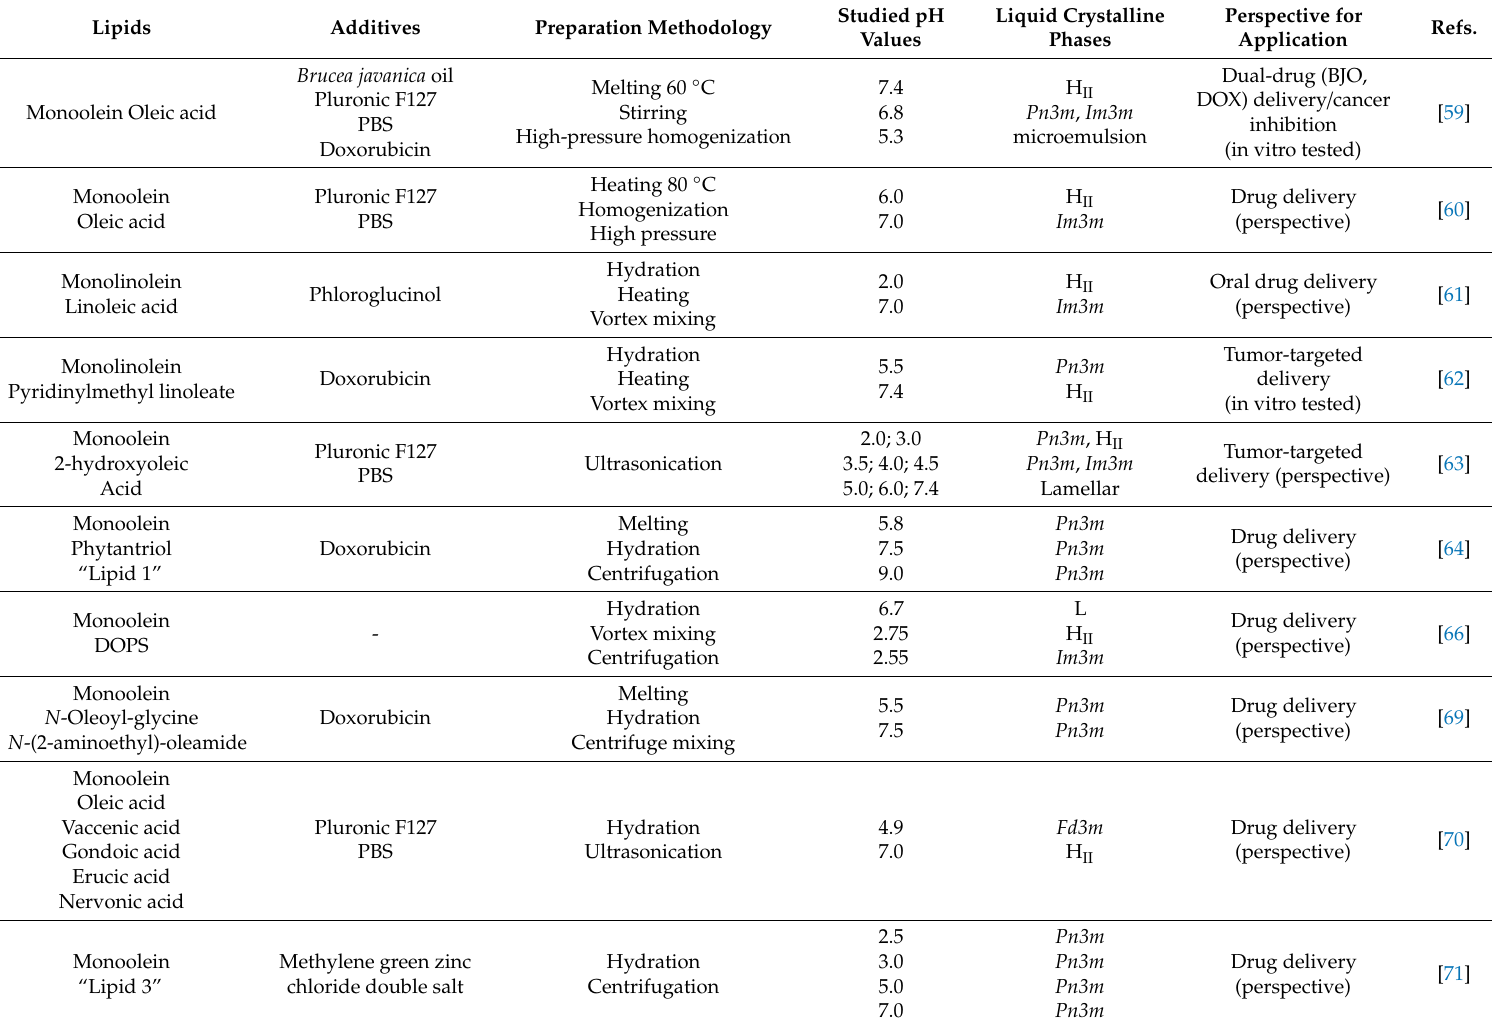
Table 1. Summary of reported compositions and main characteristics of self-assembled pH-responsive liquid crystalline mesophases and nanoparticles derived